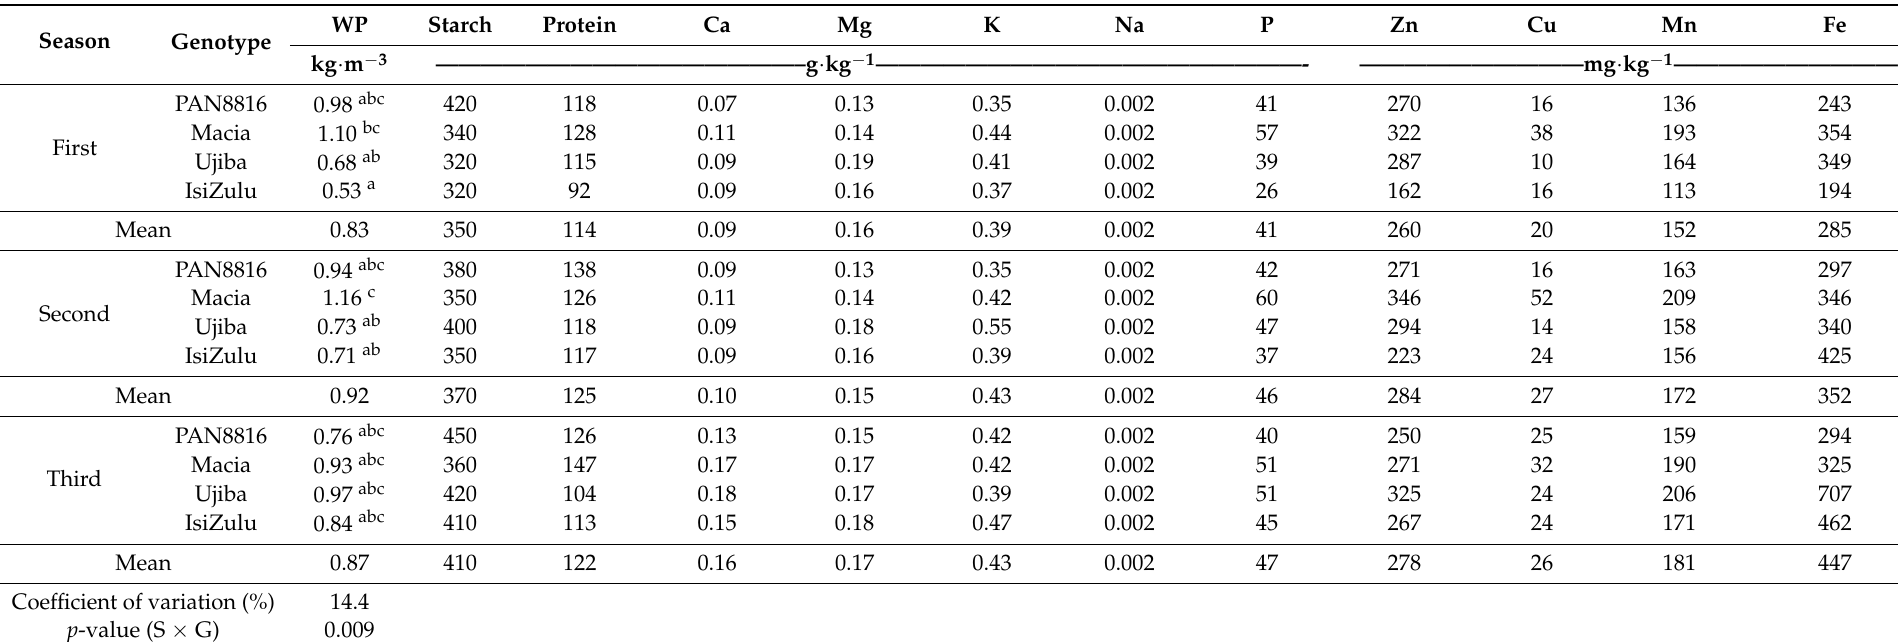
Table 3. Water productivity (WP) and nutrient density of selected sorghum genotypes at different planting